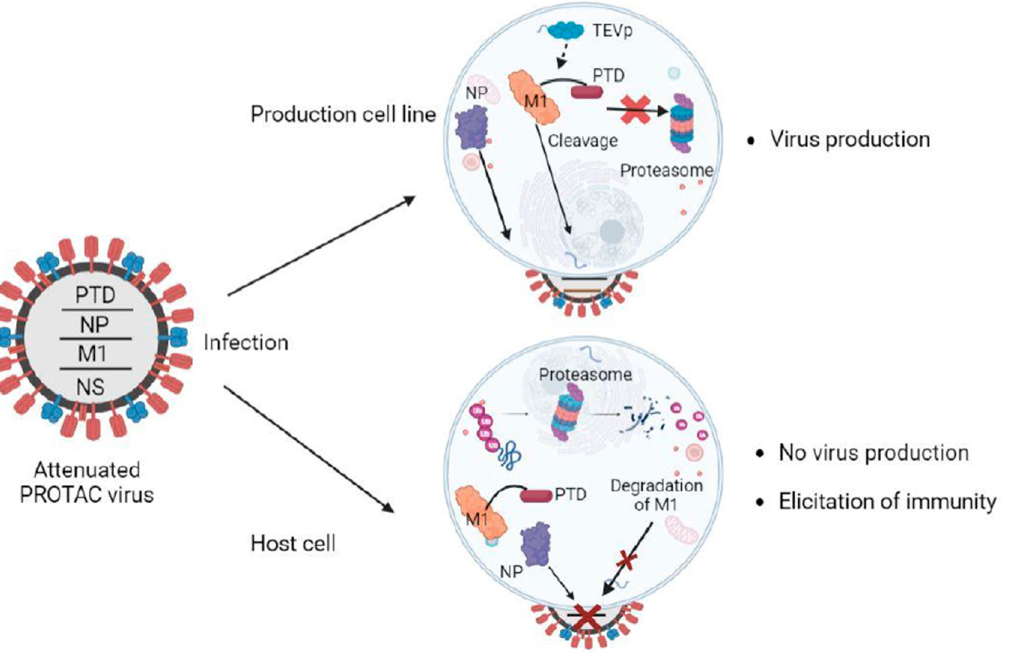
Figure 3. Overview of the PROTAC-based vaccine design. The ubiquitinated viral protein (M1-PTD) of PROTAC viruses is targeted and degraded by the proteasome in host cells, attenuating their reproduction and causing a deficit in protein synthesis. The influenza nucleoprotein (NP), which is not fused to PTD, is not degraded. In the production cell line, cells are designed to produce the TEV protease (TEVp), which cleaves the PTD, and the PROTAC viruses proliferate well for vaccine production. M1, matrix protein; Ub, ubiquitin; PTD, proteasome-targeting domain.